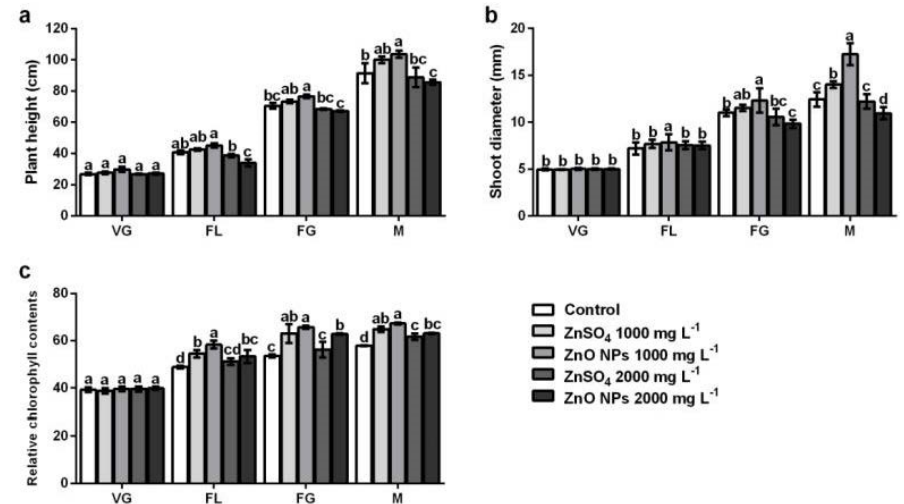
Figure 2. Effect of foliar application of ZnSO 4 and ZnO NPs on agronomic parameters ( a ) plant height ( b ) shoot diameter, ( c ) relative chlorophyll content characteristics in different phenological stages of the plant. (VG) vegetative growth, (FL) flowering, (FG) fruit development, (M) maturity. The values are the average of five repetitions. Means ( n = 5). Bars represent the standard deviation of the mean. Different letters mean that treatments were statistically diferentes (Tukey, p ≤ 0.05) and represent the differences between treatments, whitin each phenological stage.